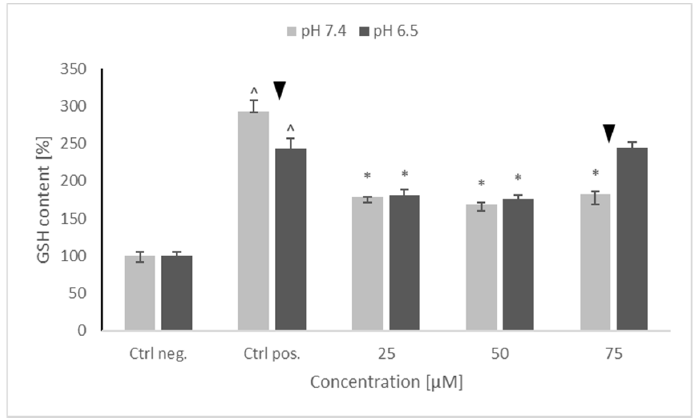
Figure 5. Glutathione (GSH) content of SH-SY5Y cells after pretreatment with NRNPs pH and expo- sure to 6-hydroxydopamine. The whiskers are lower (25%) and upper (75%) quartile ranges. ^ p ≤ 0.05, Kruskal–Wallis test vs. the negative control (Ctrl neg.; cells not treated with 6-OHDA), ▼ p ≤ 0.05, Mann–Whitney U test; differences between the different pH conditions (pH 7.4 vs. pH 6.5), * p ≤ 0.05, Kruskal–Wallis test vs. positive control (Ctrl pos.; cells treated with 6-OHDA only, without any pretreatment); n =